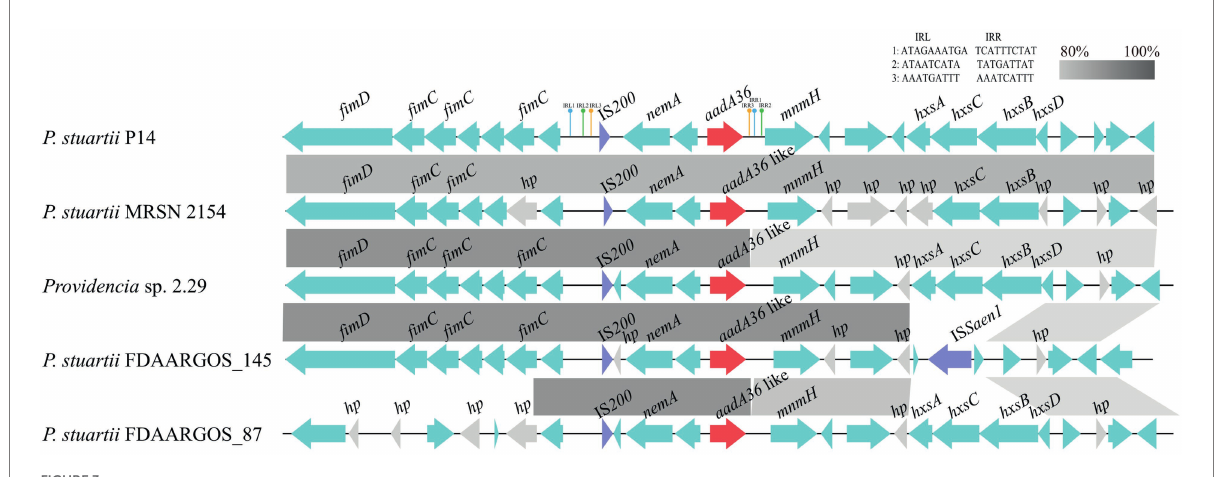
FIGURE 3 Comparative analysis of the genetic environment of the aadA36 gene-related region. The aadA36 homologous genes in different species were compared. Genes are denoted by arrows. The aadA36 and aadA36 -like genes were colored red, and the IS200 and ISSaen1 were colored purple. Gray shading denotes regions of homology (>80% nucleotide sequence identity), and hypothetical proteins (hp) are colored gray. The accession numbers of the sequences are as follows: Providencia sp . 2.29 (CP065420.1), P. stuartii MRSN 2154 (CP003488.1), P. stuartii FDAARGOS_145 (CP014024.2) and P. stuartii FDAARGOS_87 (CP031508.1).